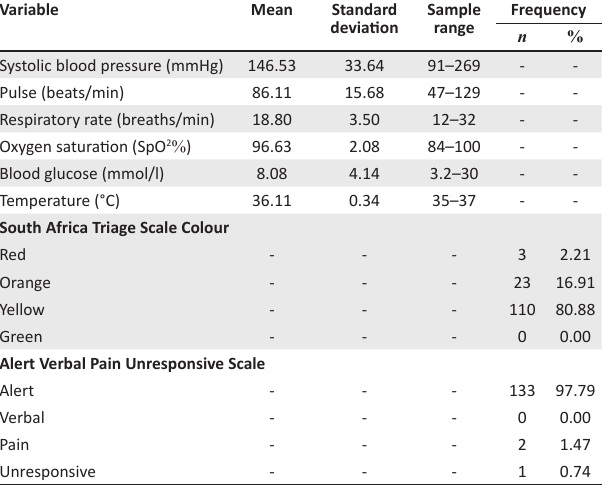
TABLE 2: Clinical presentation and triage scores.